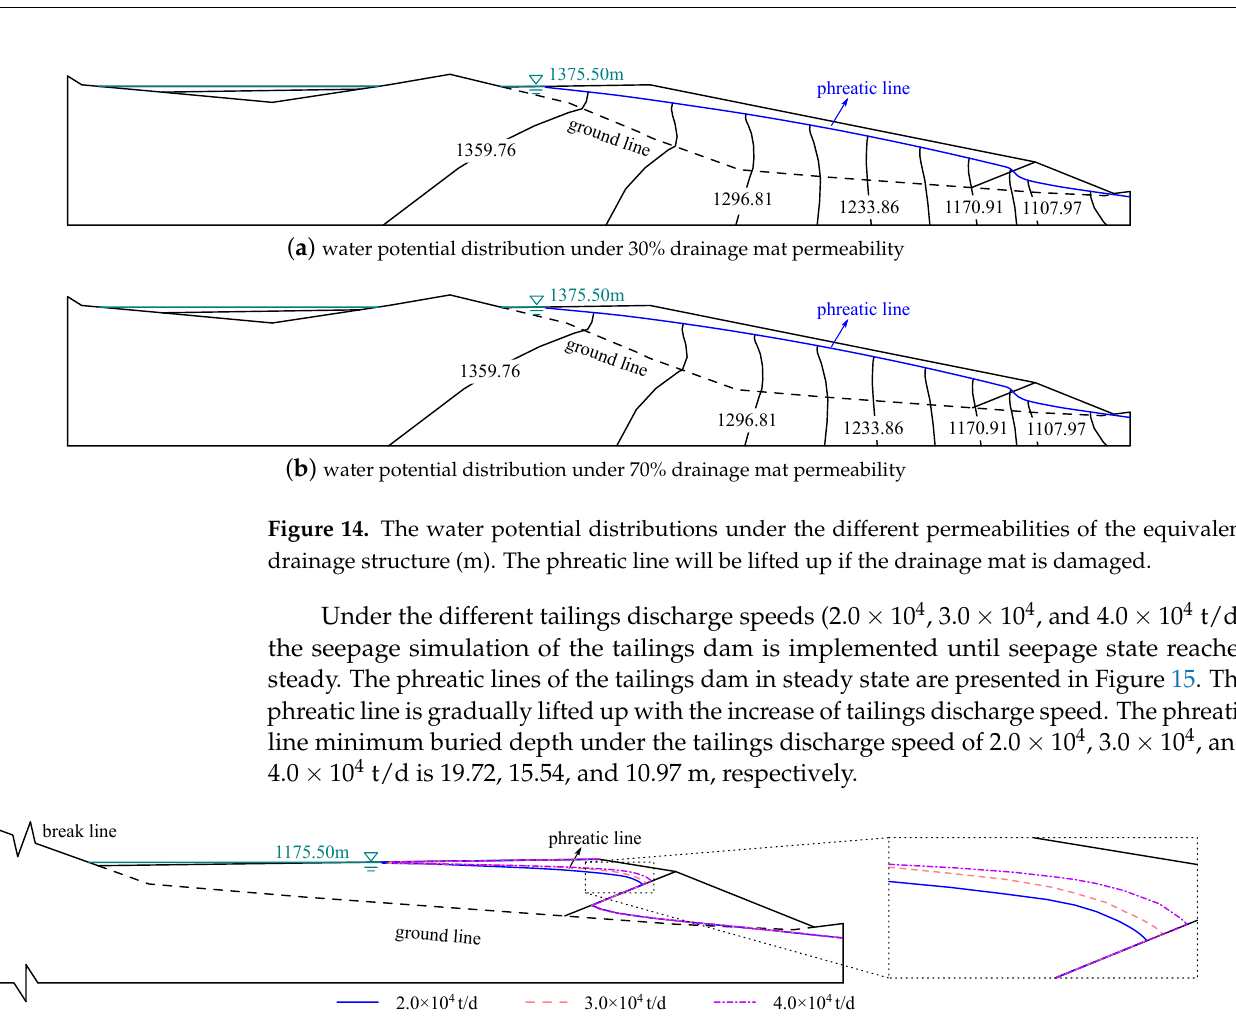
Figure 15. The effect of tailings discharge speed on phreatic line. With the increase of tailings discharge speed, the phreatic line rises.